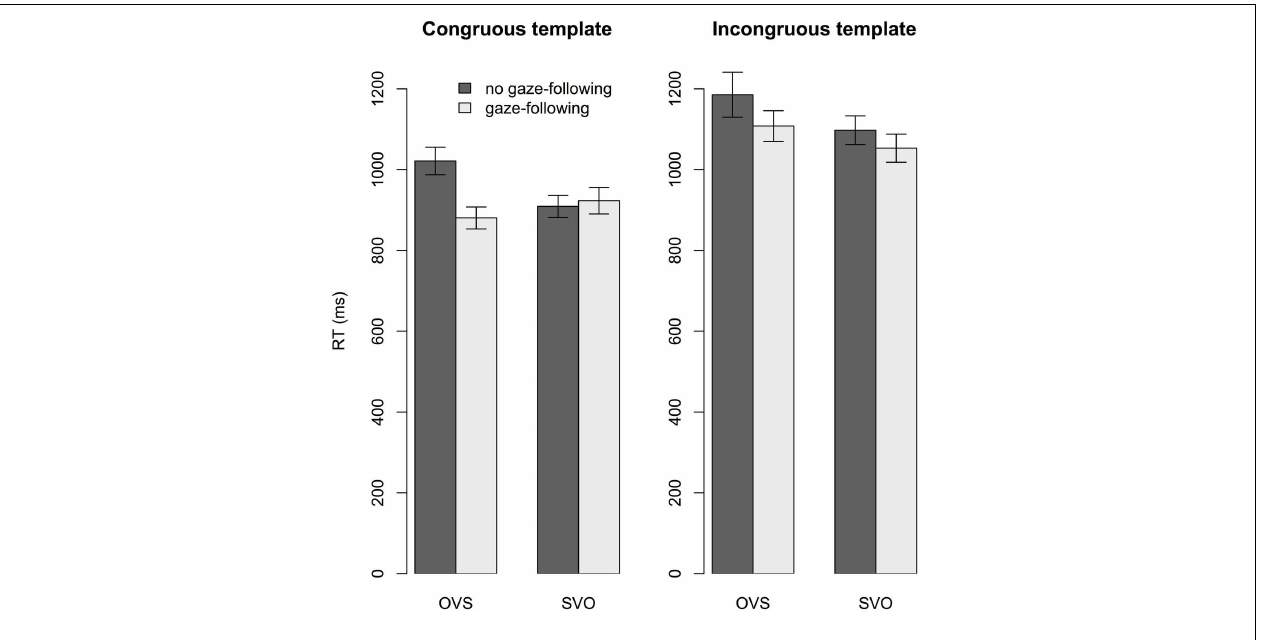
FIGURE 4 | Experiment 2: Interaction effect of gaze-following, sentence structure and congruence on response times. Since we collapsed across the factor speaker, the bars labeled “gaze-following” include both gaze and no gaze trials, whenever the target character was